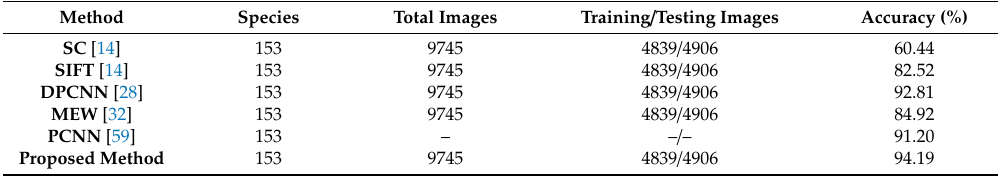
Table 6. Comparison of the proposed method with existing approaches on MEW dataset.